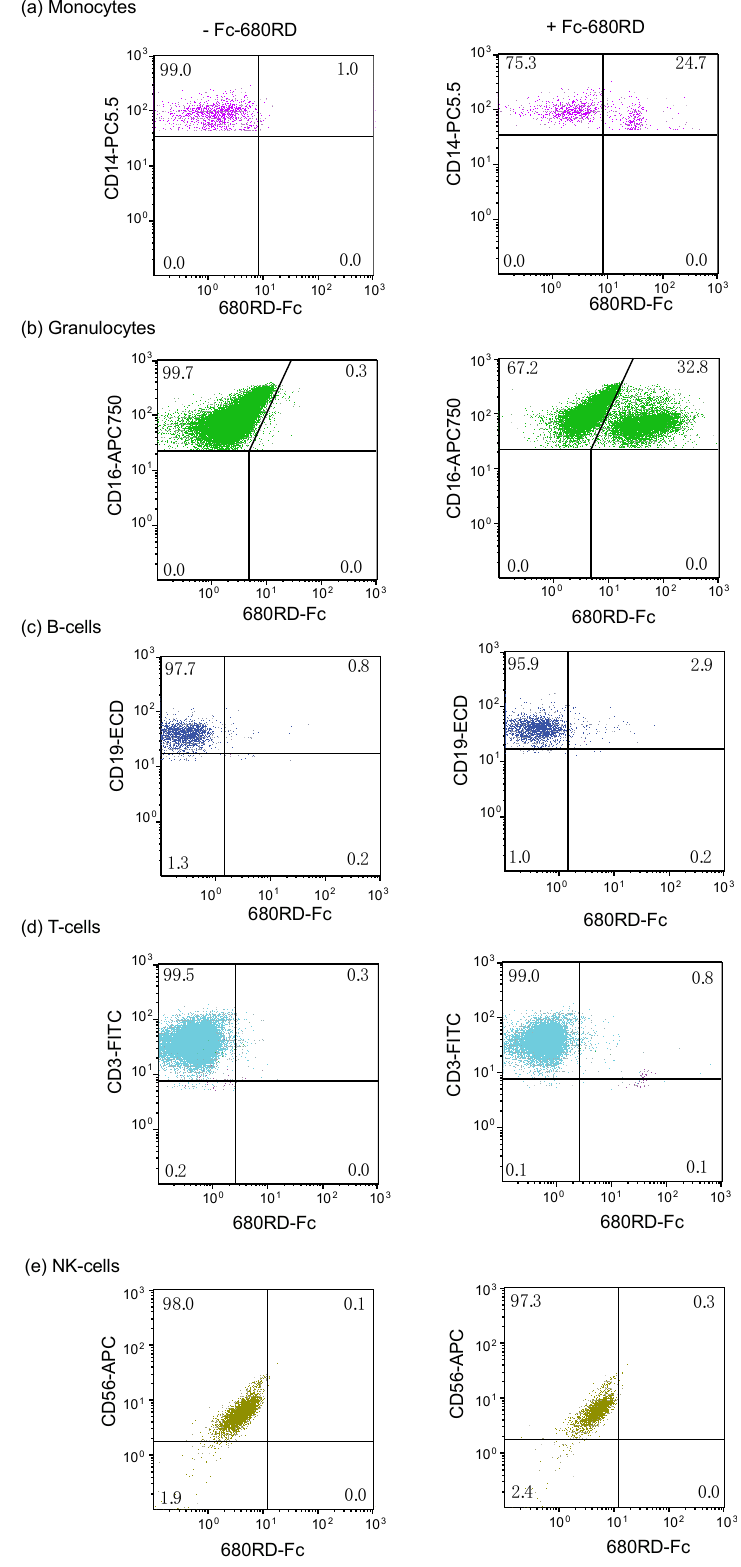
Figure 6. Fc domain probe binds monocytes and granulocytes. Human peripheral blood was incubated with an immune cell panel to differentiates between ( a ) monocytes, ( b ) granulocytes, ( c ) B cells ( d ) T cells and ( e ) natural killer (NK) cells using CD3, CD19, CD14, CD16, CD56, CD45, the IRDye680RD-Fc probe and analyzed by flow cytometry. The percent of cells is shown in each quadrant.